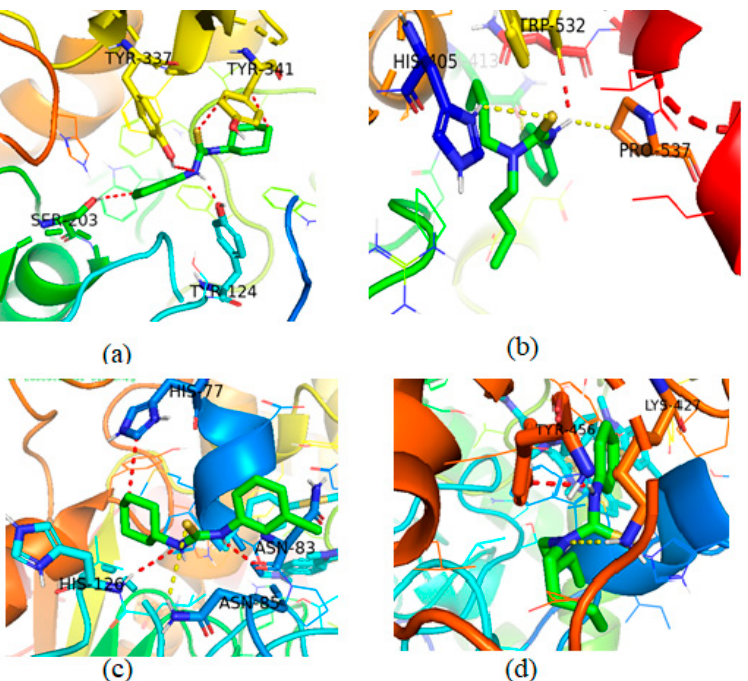
Figure 6. 3 D binding interaction modes of compounds 3 and 4 as inhibitor of AChE and BChE. ( a ) Interaction posing of compound 3 with AChE; ( b ) interaction of compound 4 with AChE; ( c ) interaction of compound 3 with BChE and ( d ) interaction of compound 4 with BChE.